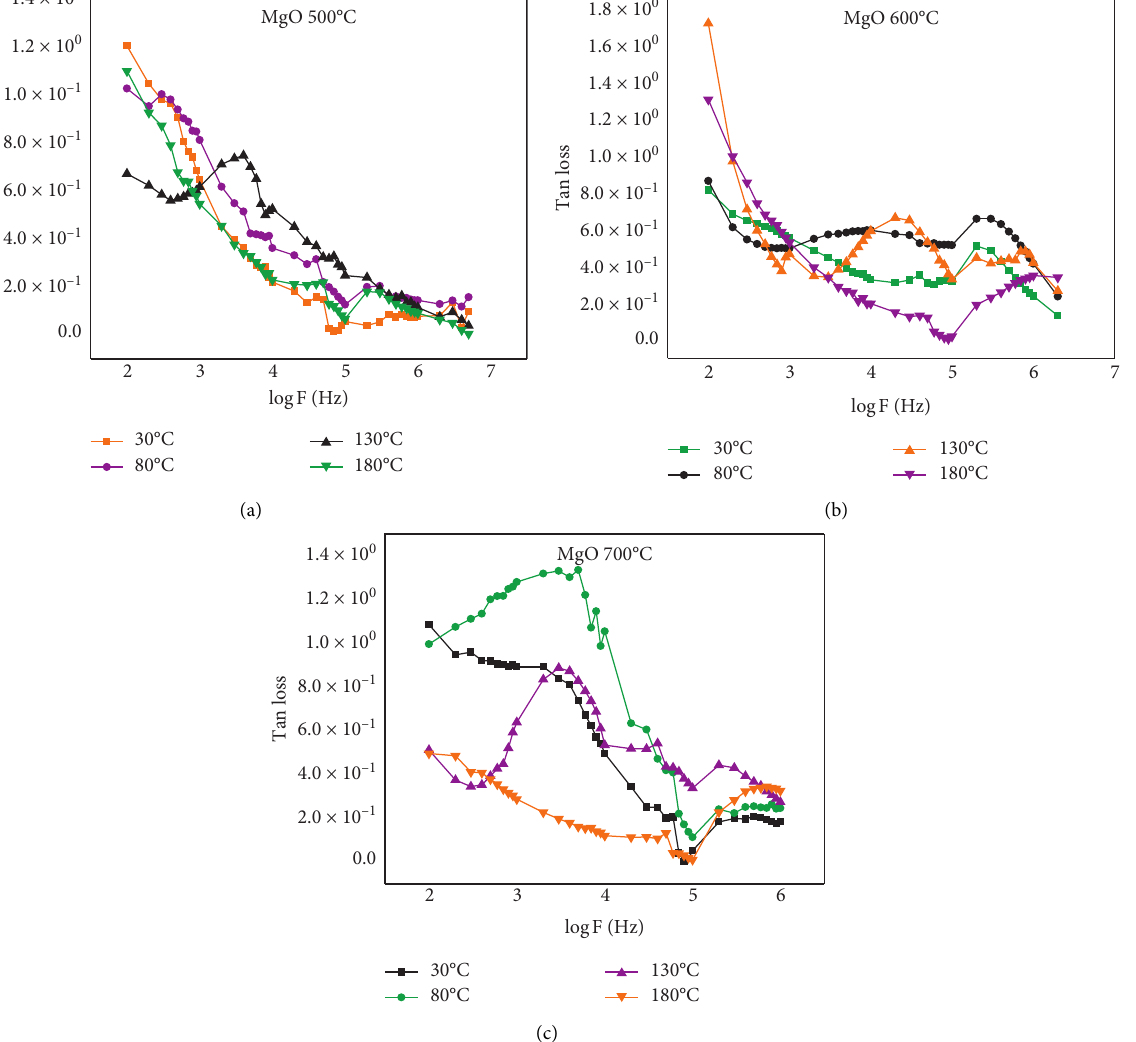
Figure 16: Tan loss of MgO nanoparticles at 500 ° C (a), 600 ° C (b), and 700 ° C (c) with different